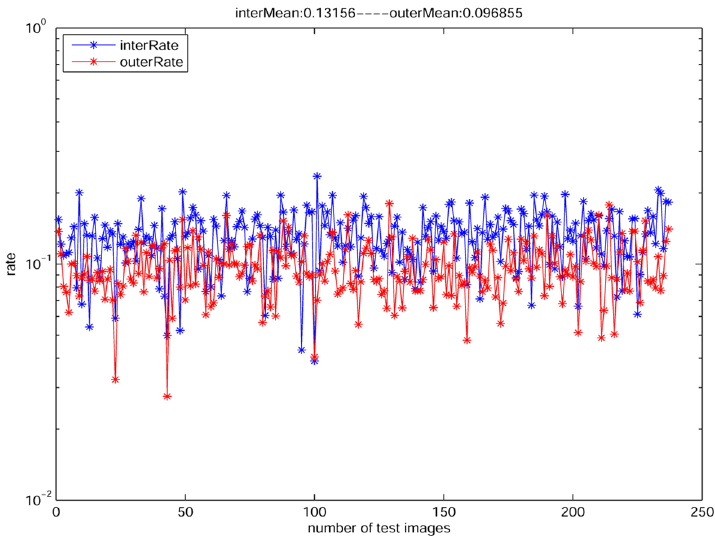
Fig 7. The rates of A E O (blue points) and A E F (red points) for Eq (7) on the open dataset. Note that Eq (7) is A O A F reasonable since the red points approach to the blue points. The average rate of the 237 images is 0.132 for the blue points and 0.097 for the red points. The mask is randomly with 4 unknown region. 25